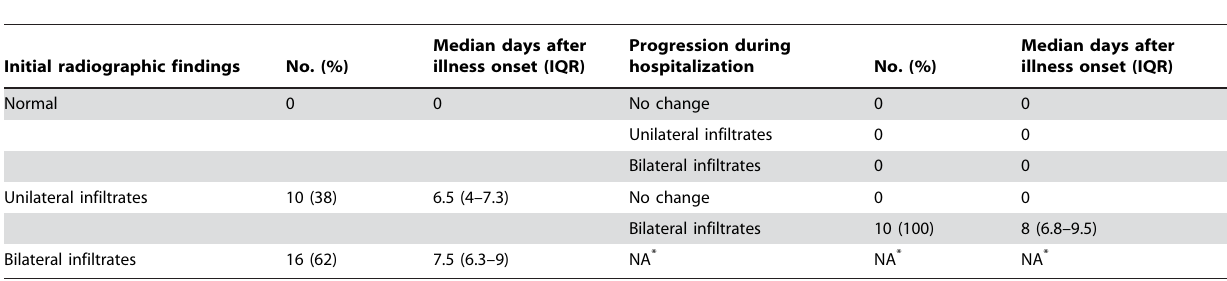
Table 2. Initial chest radiographic findings and progression during hospitalization of 26 H5N1 cases, China.